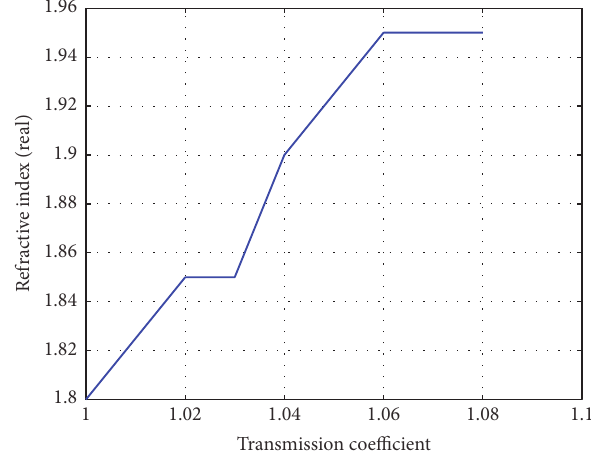
Figure 11: Plot depicting an almost linear relationship between the real component of refractive index and transmission coefficient for a radius ratio of 2.